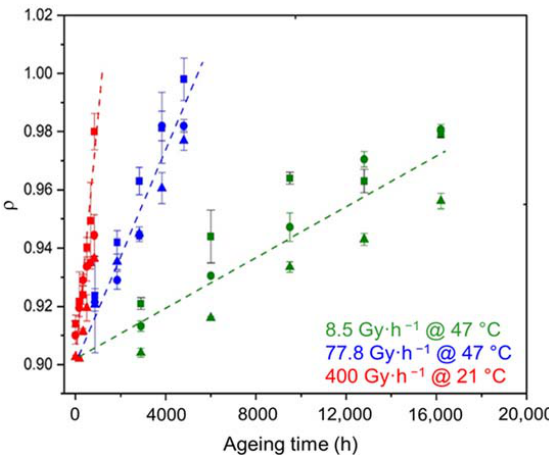
Figure 8. Changes in the density of the Si ‐ XLPE matrix filled with 0 phr ( □ ), 25 phr ( ), and 50 phr ( ) of ATH, during its radio ‐ thermal exposure in air under 8.5 Gy ∙ h − 1 at 47 °C (green), under 77.8 Gy ∙ h − 1 at 47 °C (blue), and under 400 Gy ∙ h − 1 at 21 °C (red). However, chemi ‐ crystallization is not the only phenomenon responsible for the in ‐ crease in the density of the Si ‐ XLPE matrix during radio ‐ thermal exposure. Indeed, oxy ‐ gen consumption leads also to a significant increase in the density of its amorphous phase (see Figure 9), so that the total increase in the density of this semi ‐ crystalline polymer must be written as follows [33]: